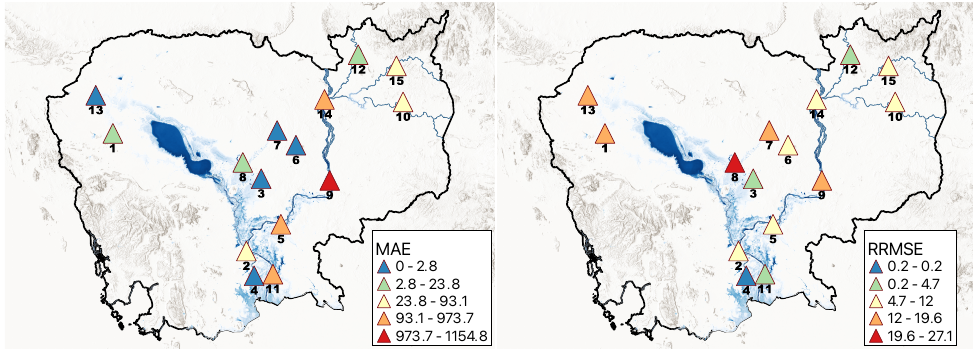
Figure 5. The model’s performance against the observation discharge for different monitoring stations. The statistical performance parameters include MAPE ( left ) and MAE ( right ). Table 5. Results of validating the Rating Curve for fifteen different stations in